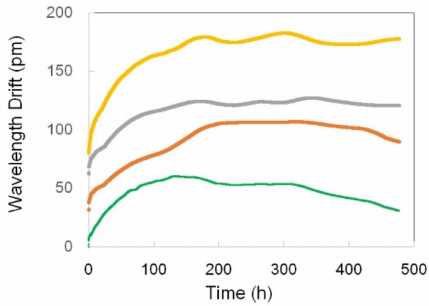
Figure 23. Wavelength drift at 900 ◦ C of the Type-a FBGs that were pre-annealed at 1000 ◦